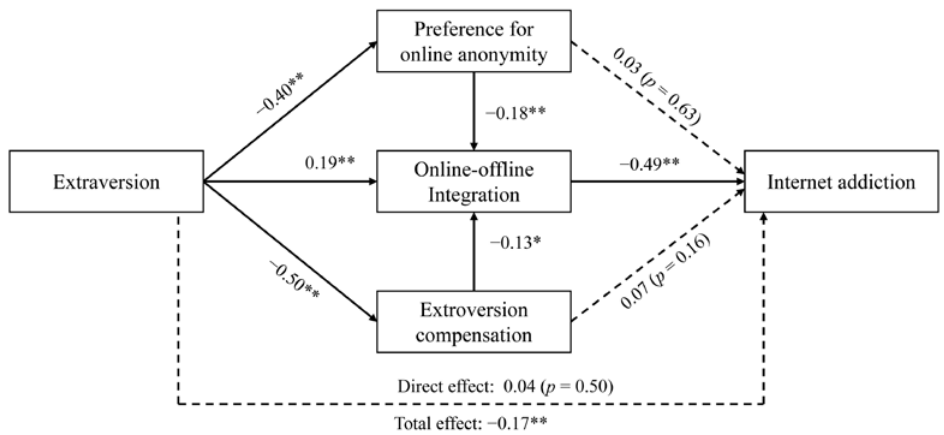
Figure 2. Results of the serial mediation model from extraversion to internet addition. Coefficients are standardized betas, * p < 0.05, ** p <